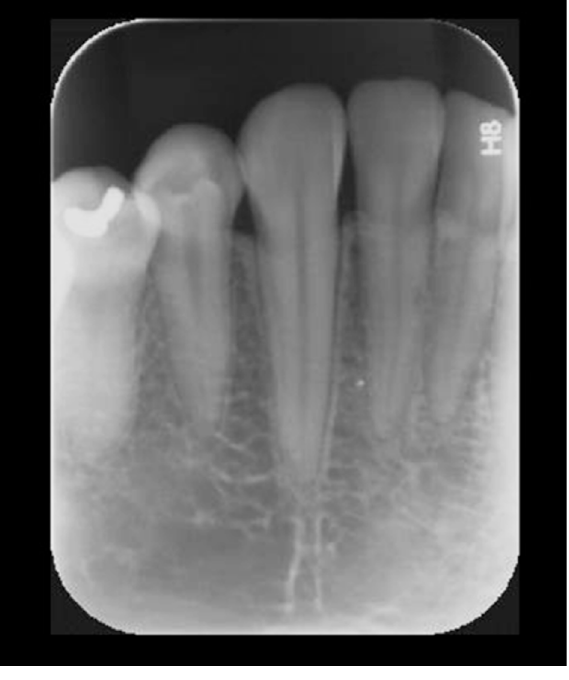
Figure 1. A periapical radiograph imported into Adobe ® Pho- toshop ® CS5. We selected the lasso polygonal tool from the tool